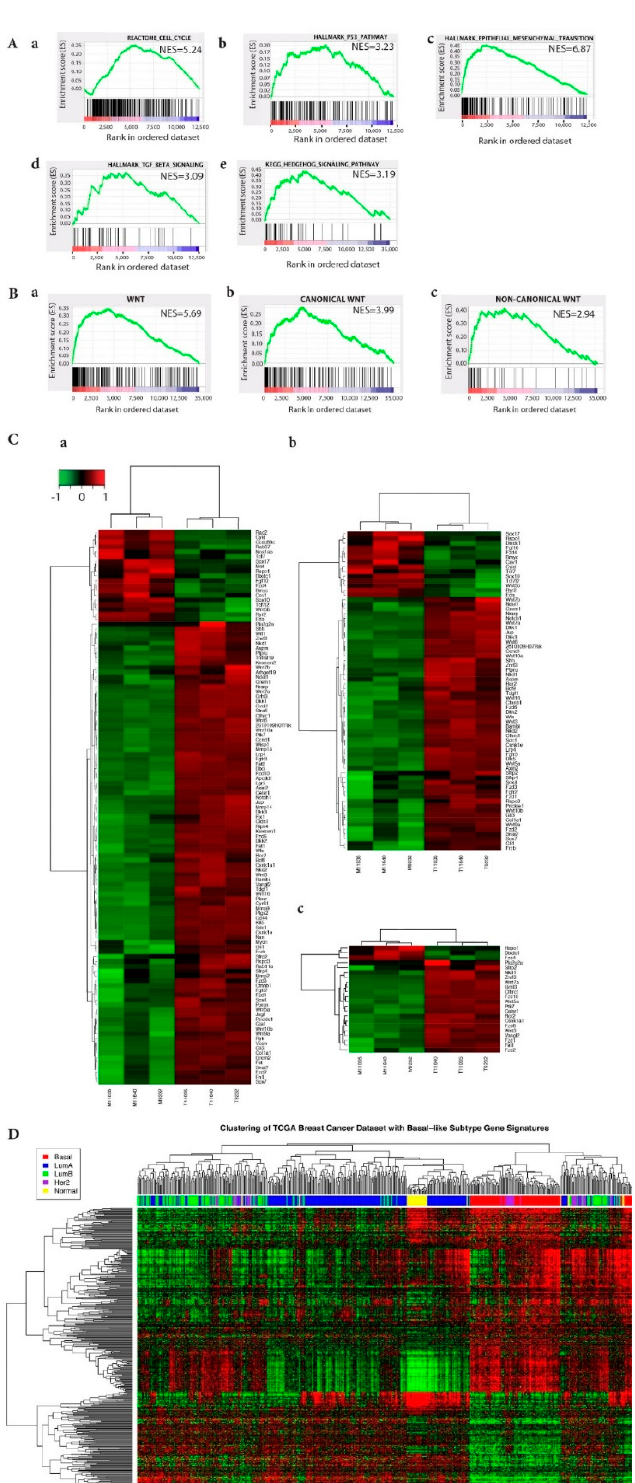
Figure 2. Signaling pathway signatures of ATF3-induced tumors are similar to those of human BLBC. ( A ) GSEA enriched gene sets cell cycle (a), p53 (b), EMT (c), TGF-beta (d), and Hedgehog